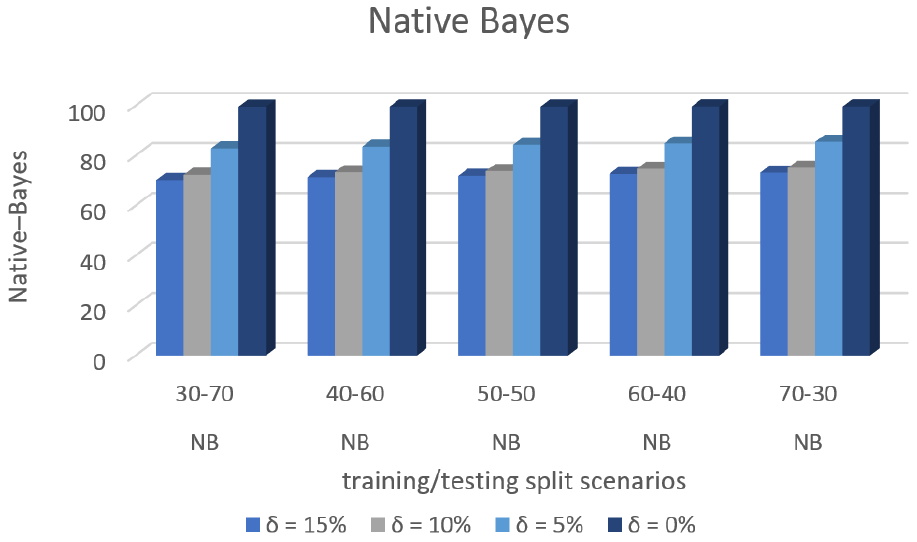
Figure 17. Accuracy Prediction for Dataset 3 using Native–Bayes